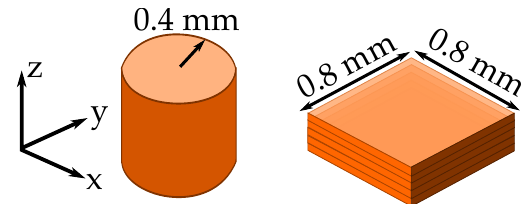
Figure 3. Minimum xy -axis resolution using the conductive filament with the available 3D-printer for different volumetric surfaces: circles and